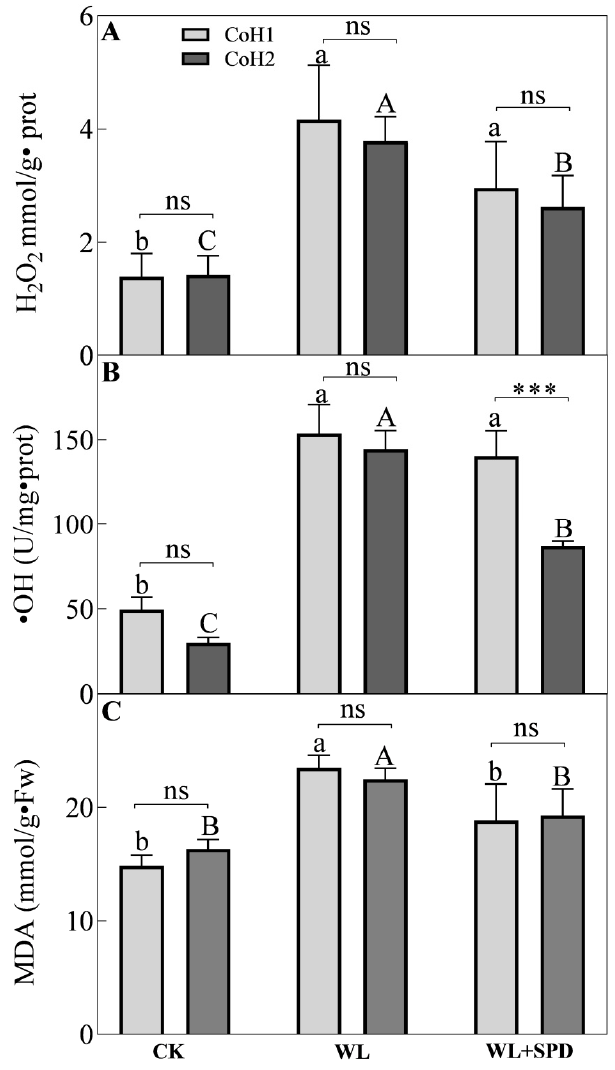
Figure 3. H 2 O 2 ( A ), • OH ( B ), and MDA ( C ) levels in C . oleifera under WL and exposed to SPD treatment. The bars on the top show SE (n = 5), and different lowercases and uppercases indicate significant differences among CK, WL, and WL + SPD treatments within each species according to Tukey’s multiple comparison test, respectively ( p < 0.05). The signs such as *** and ns in the figures concern the significance difference between the same treatment for CoH1 and CoH2 (***, p < 0.0005; ns , Not significant). CK: control; WL: waterlogging; SPD: spermidine.